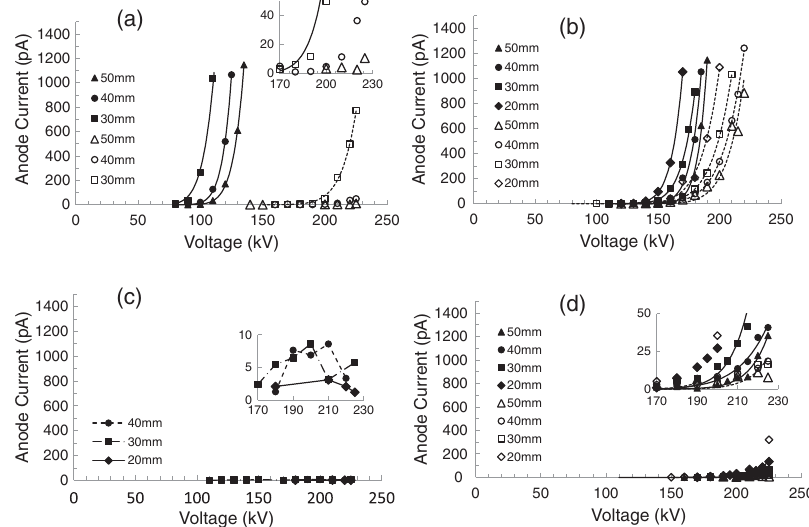
FIG. 3. Field emission current versus bias voltage and anode/cathode gap spacing for (a) DPP stainless steel, (b) fine-grain Nb, (c) large-grain Nb, and (d) single-crystal Nb. Each plot shows field emission behavior before (solid symbols) and after (open symbols) krypton processing, except for large-grain Nb which did not require krypton processing. Insets show an enhanced view of the low current data points. For all cases except large-grain Nb, the lines between data points represent Fowler-Nordheim